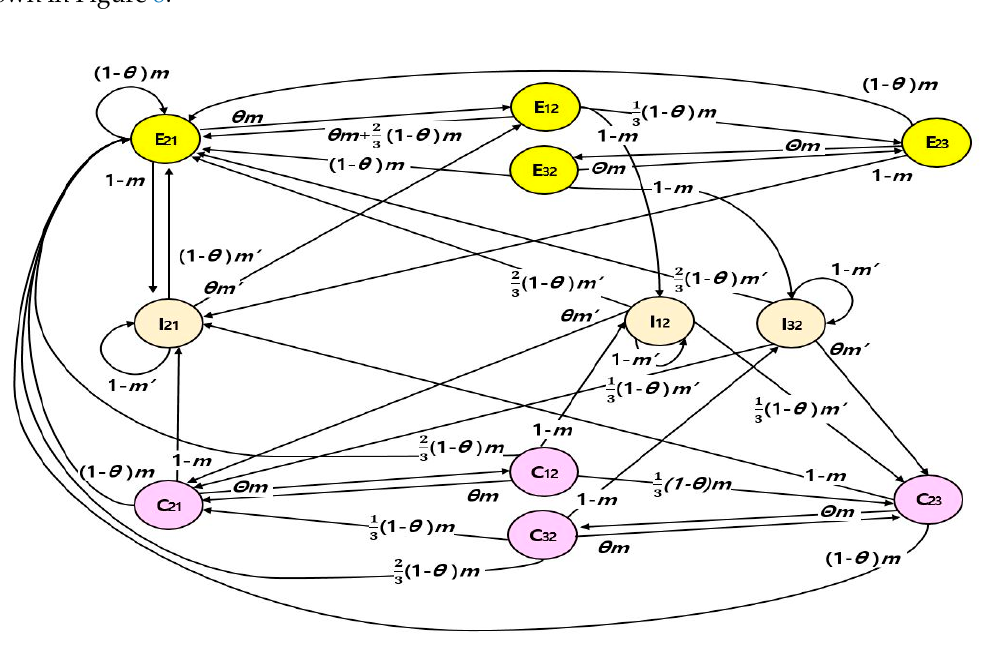
Figure 8. State transition diagram for a 3Z system.